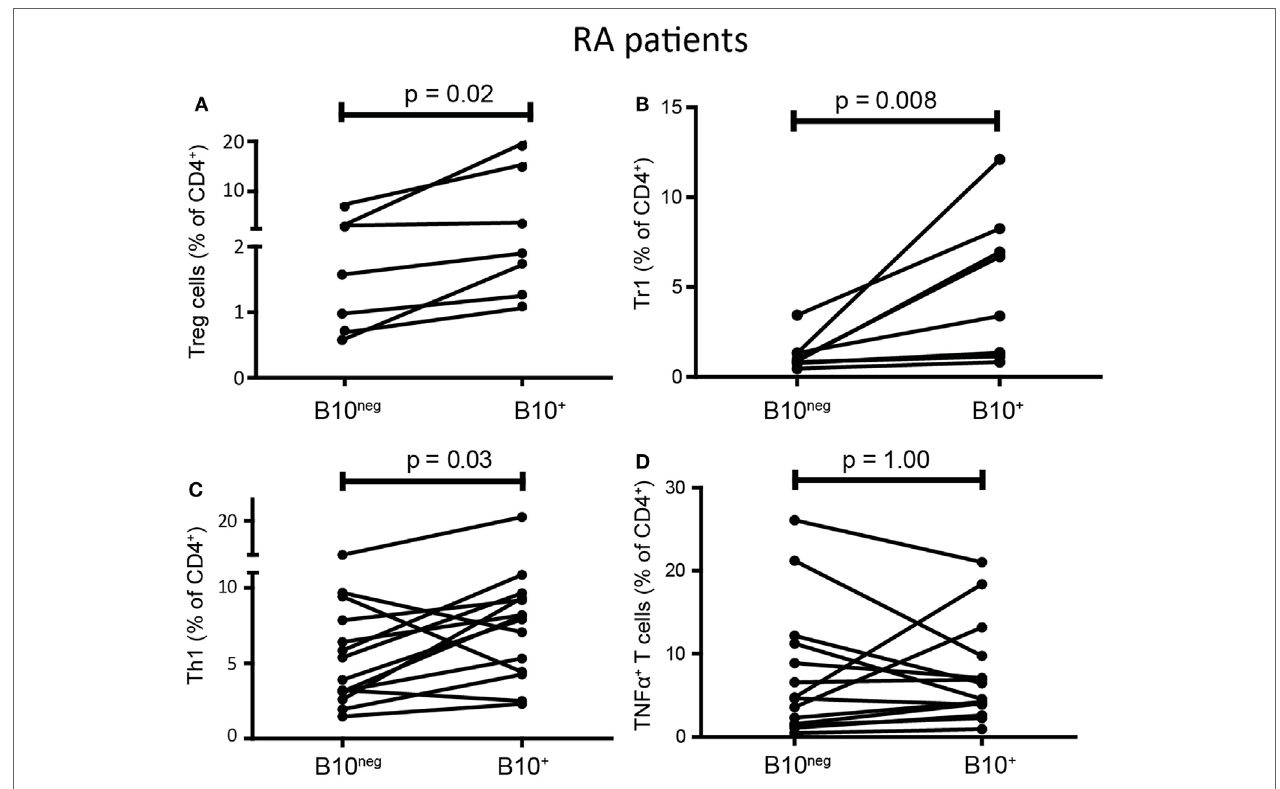
FigUre 5 | B10 + cells from rheumatoid arthritis (RA) patients could induce regulatory T (Treg) cells and Tr1 but also increased T helper 1 (Th1). CD4 + CD25 − T cells were cultured with autologous B10 + or B10 neg cells from RA patients and percentages of Treg cells (a) , Tr1 (B) , Th1 (c) , TNF α + T cells (D) were assessed after 72 h. Wilcoxon matched pairs test. N =